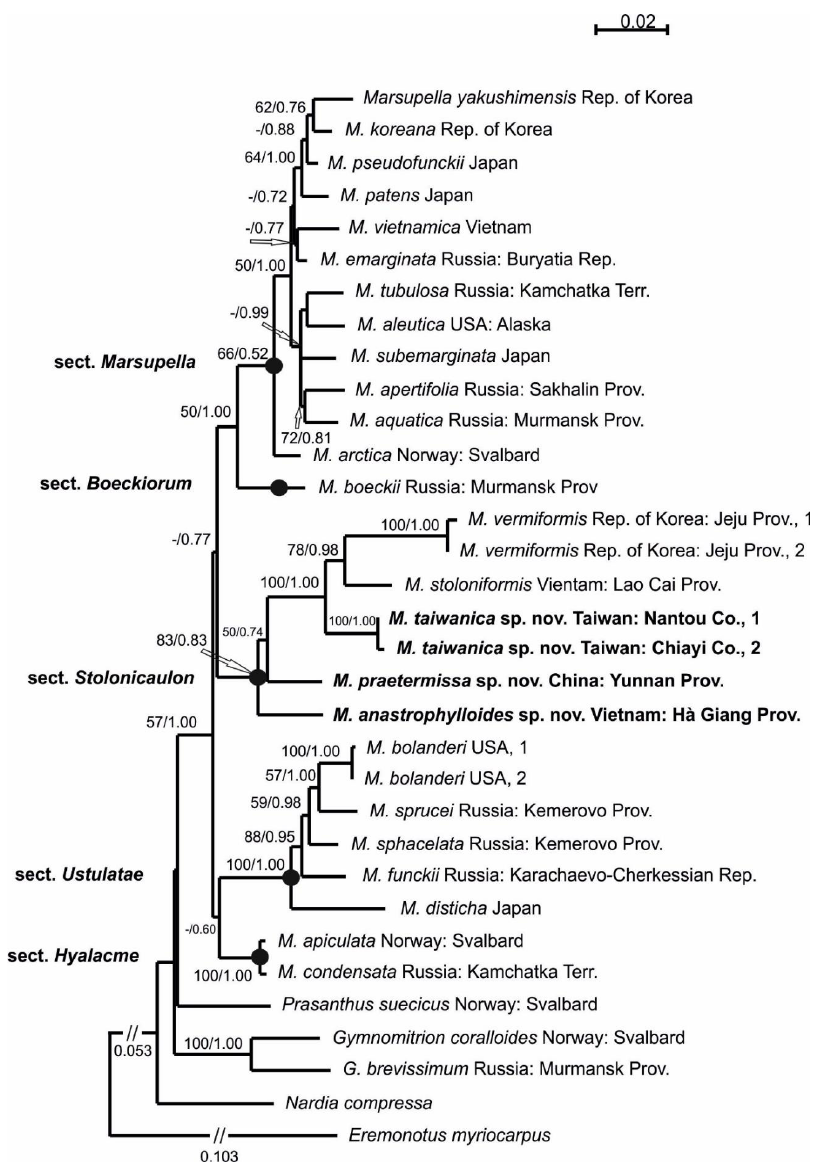
Figure 1. Phylogram obtained in a maximum likelihood calculation for the genus Marsupella based on ITS1-2+ trn L-F dataset. Bootstrap support values of maximum likelihood analysis more than 50% and Bayesian posterior probabilities more than 0.50 are indicated.